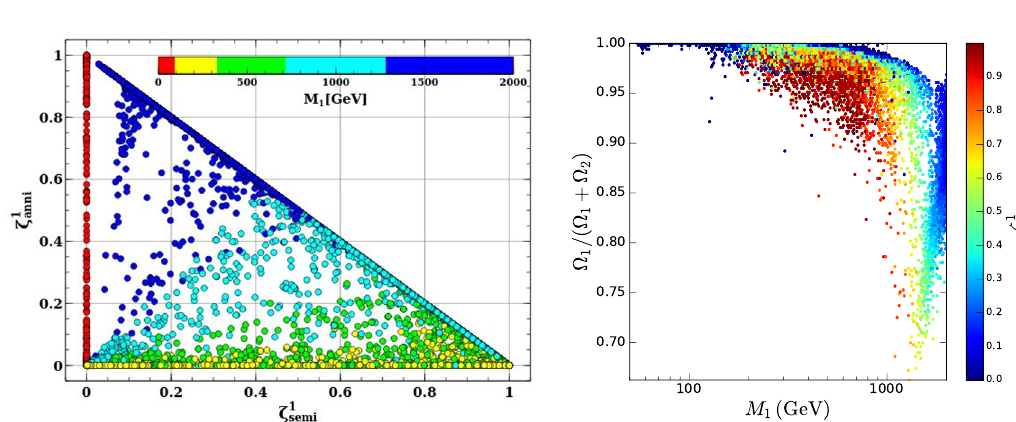
Figure 10 . Semi-annihilation and annihilation fractions (left panel) and the relative contribution of (cid:30) 1 to the total DM relic abundance as a function of M 1 (right panel) for the scan with 0 : 1 (cid:20) (cid:22) S 1 (cid:20) 10 TeV, (cid:22) S 2 = 0 and (cid:21) 3 i = (cid:21) 412 = 0.